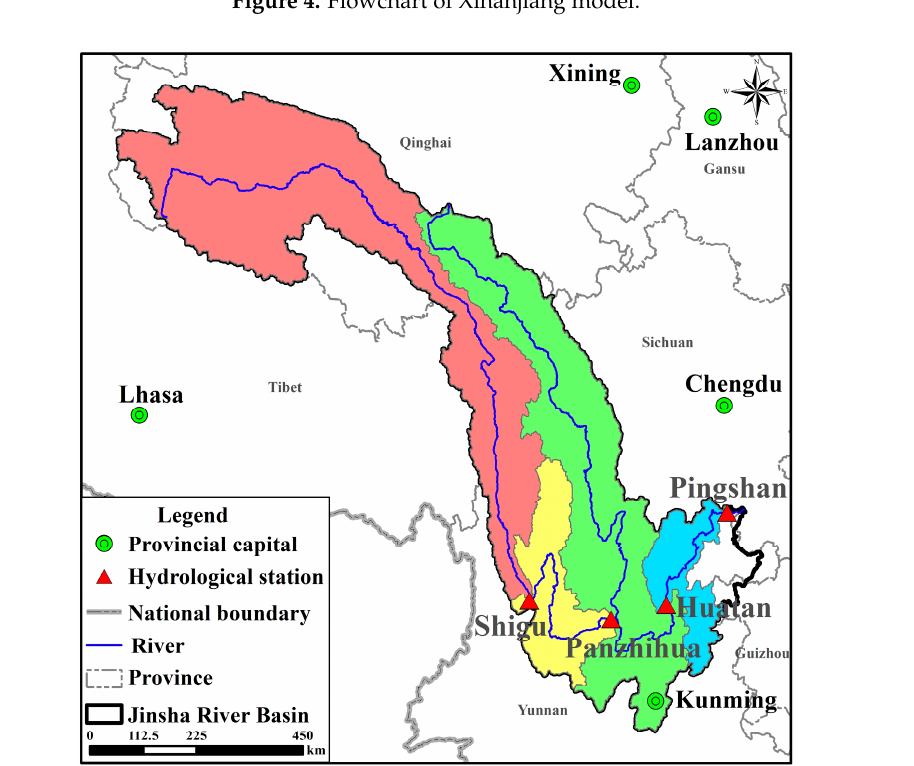
Figure 4. Flowchart of Xinanjiang model.